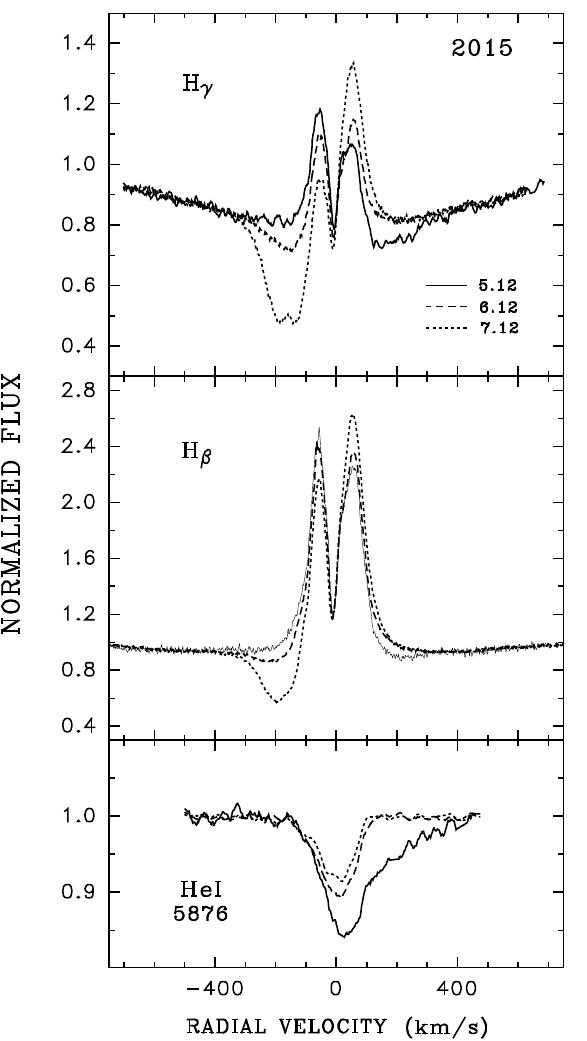
Figure 4. Variations of the line profiles for H γ , H β , and He I λ 5876 in the spectrum of HD259431 during three epochs on 5–7 December 2015. X-scale is the same for all three plots.